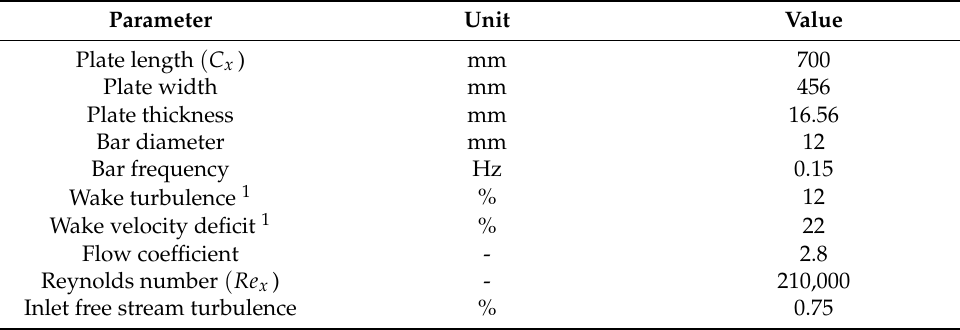
Table 1. Test section and inlet flow